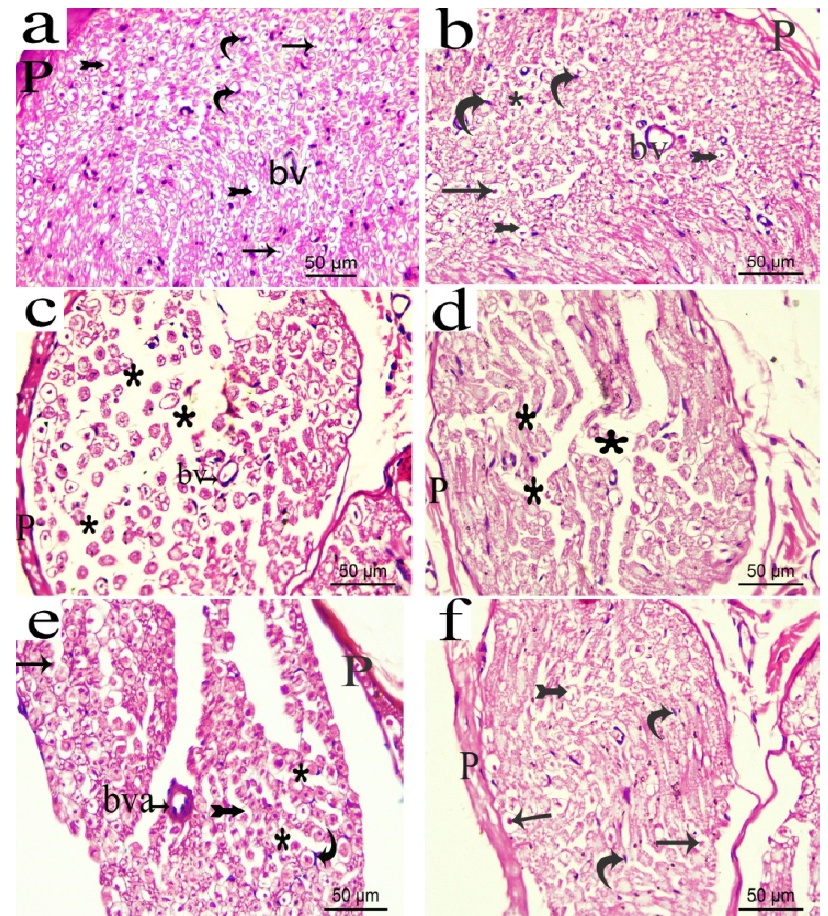
Figure 13. Photomicrograph (H&E × 400) of transverse sciatic nerve sections from: normal ( a ); sham ( b ); CCI ( c ); pregabalin ( d ); H. campechianum flower extract (200 mg/kg) ( e ); H. campechianum flower extract (400 mg/kg) ( f ) rats. Rats received different treatments for 14 days after which the animals were sacrificed and tissues were collected. Arrow, bifid arrow, curved arrow and asterisks illustrate axoplasm, area of dissolved myelin, Schwann cells nuclei and wide separation between the nerve fibres, respectively. (bv) blood vessel, (bva) dilated blood vessel, (P) perineurium. Scale bar, 50 μm x 400.